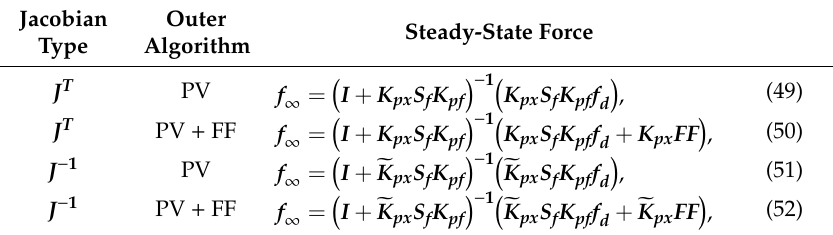
Table 3. Response force of the control force with incremental position inner